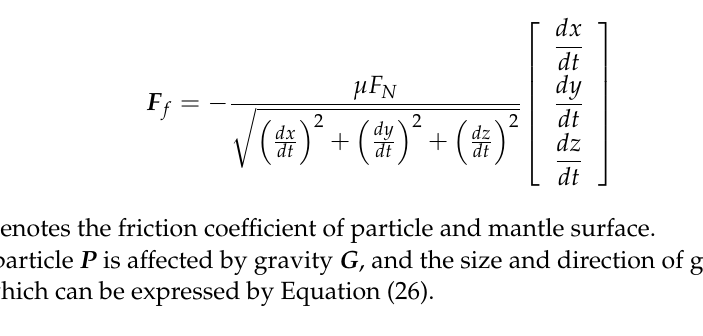
The friction force F f of the particle P is proportional to the support force F N , and the direction is opposite to the movement direction of particle P relative to the mantle surface, so the friction force F f of particle P can be expressed by Equation